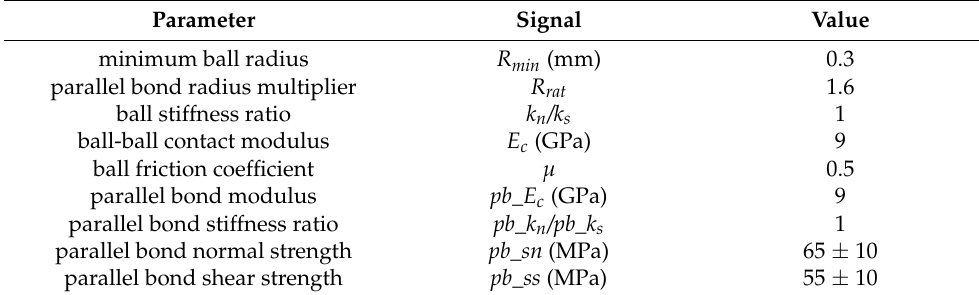
Table 1. Micromechanical parameters of shale sample model.